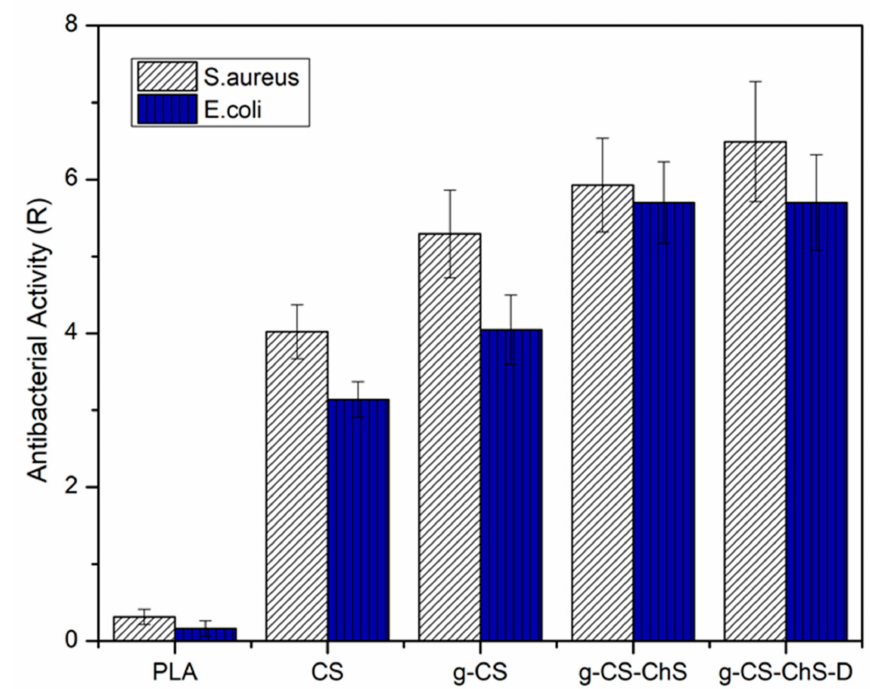
Figure 7. Antibacterial activity of untreated, CS and/or ChS coated, lomefloxacin loaded PLA